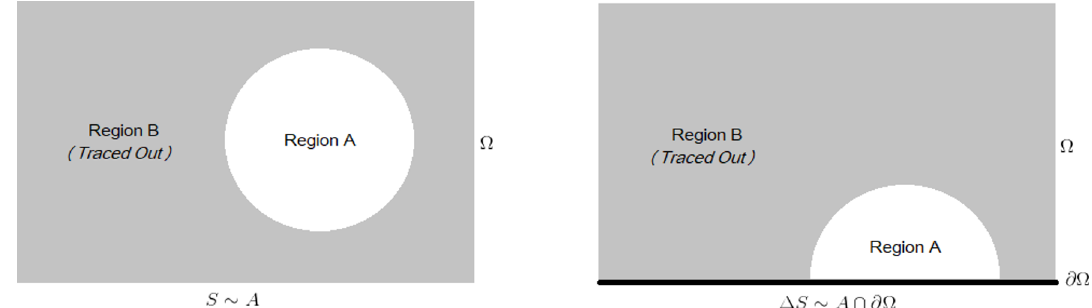
Figure 1 . The entanglement entropy of Region A in a spacetime without boundary is proportional to its surface area, S (cid:24) A . If one introduces a boundary with associated boundary physics, then the di(cid:11)erence in entanglement entropy for di(cid:11)erence choices of boundary physics scales with the intersection of the region with the boundary, (cid:1) S (cid:24) @A = A \ @ (cid:10).